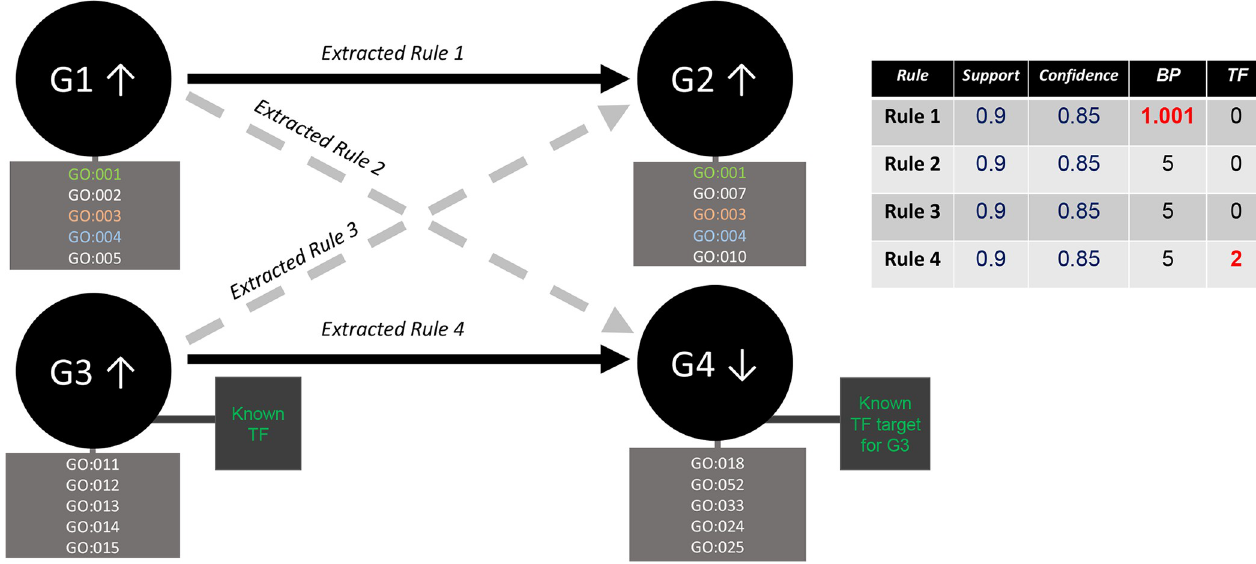
Fig 2. Role of biological quality measurements for the functional assessment of each discovered gene-gene relationship. While all extracted rules present acceptable and identical quality metrics (support = 90% and confidence = 85%), only the rule 1 presents a good BP measure value (remember that the range of values available for the BP measure was from 5 to 1, being the values near to 1 the ones corresponding to a higher number of GO matches between LHS and RHS genes). On the other hand, it is only the rule 4 the one presenting a good value for the TF measure (whose range of values was from 0 to 3, being 3 the maximal score for indicating a true TF-target gene relationship). The figure illustrate how the functional validation of results is critical to discern between spurious associations and true phenomena of interaction.